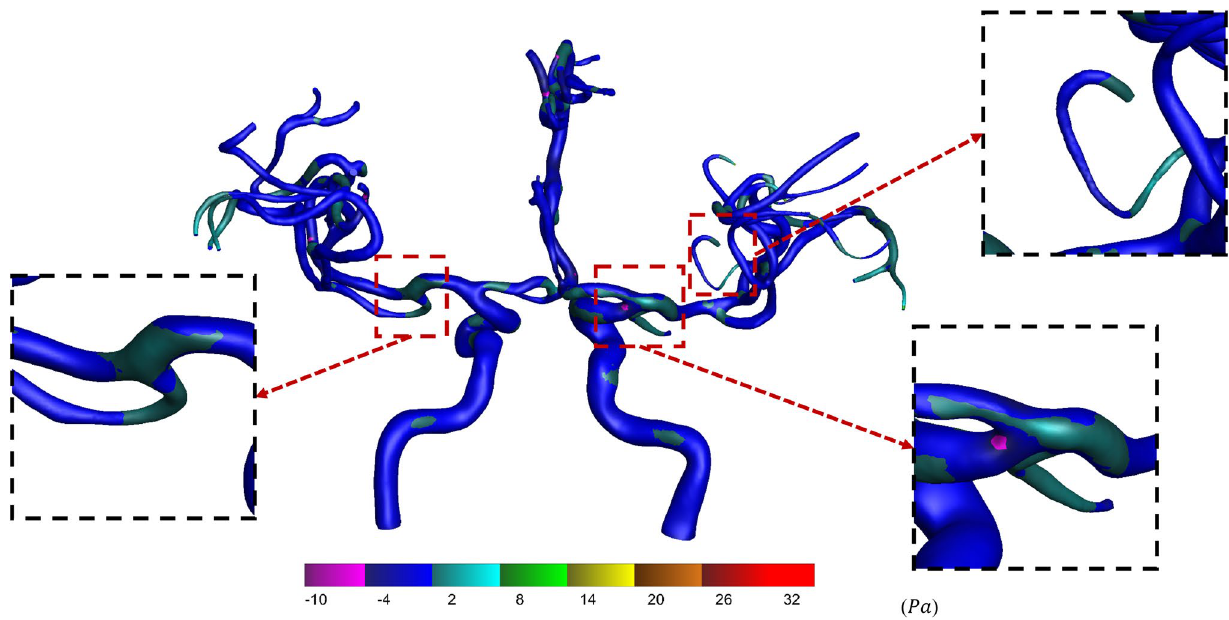
Fig. 16 WSS distribution and zoom-in on the areas near the stenosis, and the branching for case